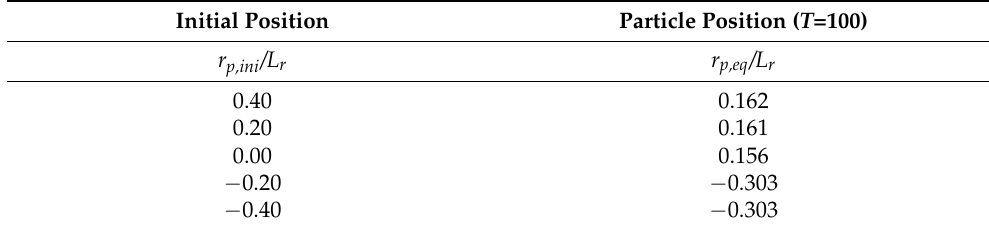
Figure 8. Segré–Silberberg effects at different initial positions for 𝑙 = 400 cells, 𝑅𝑒 = 32 and 𝐶 = 0.10. ( a ) Time history of particle behavior for 100 non-dimensional time. ( b ) Particle position at 𝑇 = 100 in asymmetric velocity profiles, and theoretical velocity profiles of straight channel ( R c / L r = ∞ ) . Table 5. Value of initial particle position and particle position at 𝑇 = 100 .